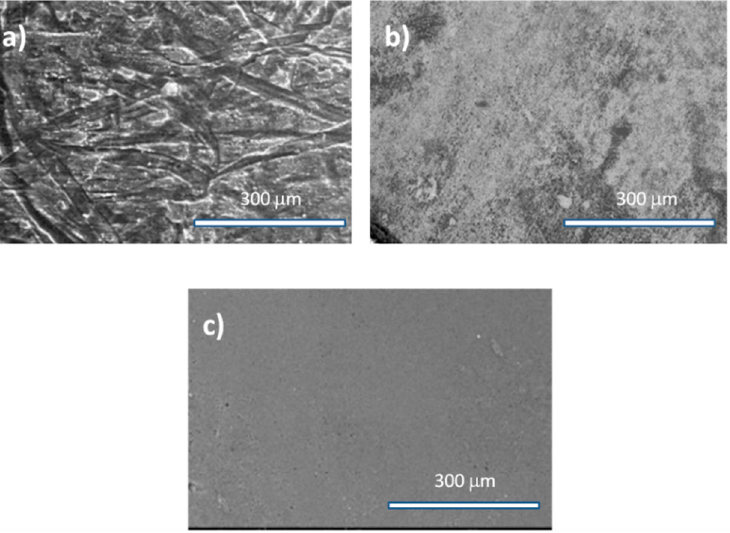
Figure 2. Scanning electron microscopy of bioplastic film surfaces: ( a ) from crude rapeseed cake; ( b ) from a defatted rapeseed cake; ( c ) from a deproteinized rapeseed cake.